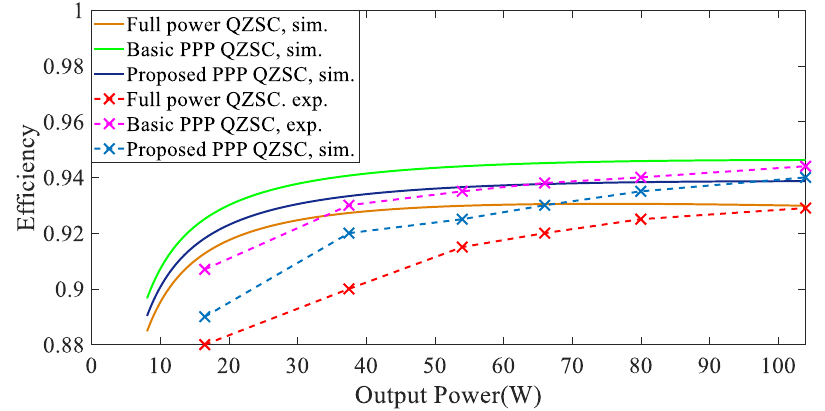
Figure 17. Experimental result for efficiency comparison of the three discussed converters.